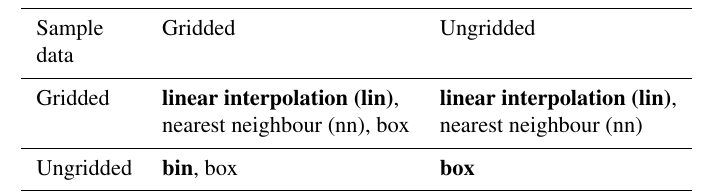
Table 3. An outline of the permutations of collocations types, as a function of the structure of the data and sampling inputs, the default in each case is shown in bold. The available kernels are described in Table 4. Each collocation algorithm is described in more detail in Sects. 4.3.1–4.3.4.